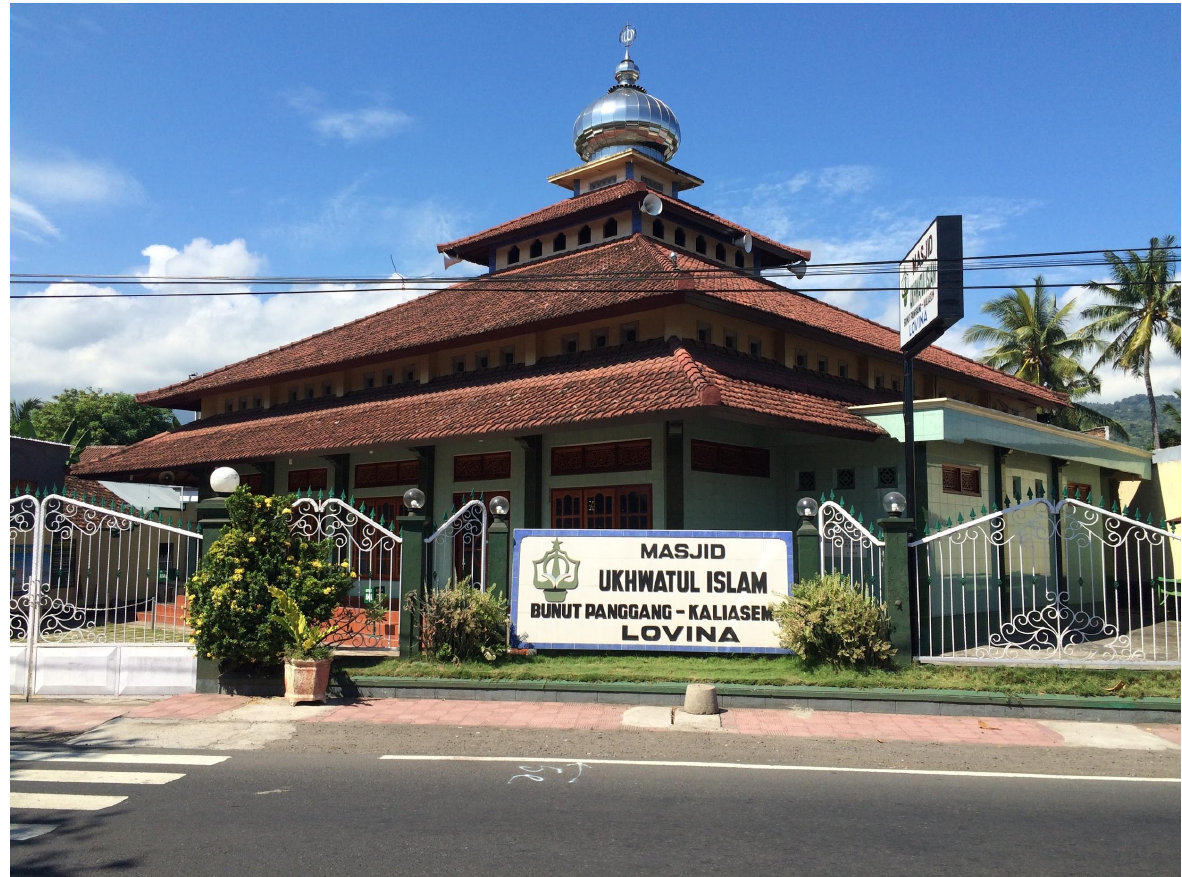
Figure 2. Ukhwatul Mosque with loudspeakers in Lovina, north Bali. Photo by the